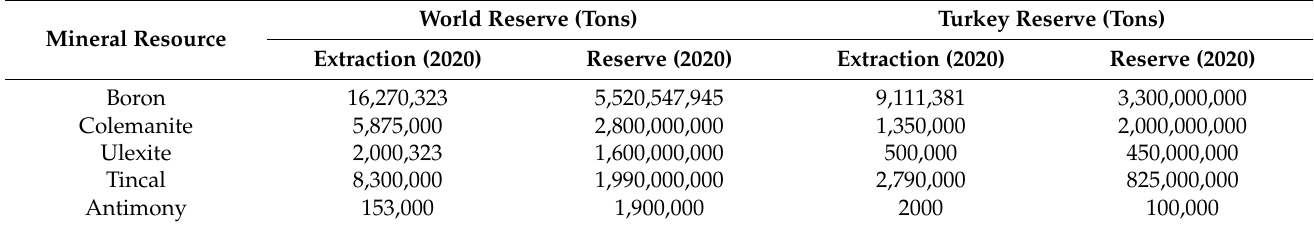
Table 4. Reserve and annual subtraction amounts for the CML method (the year 2020) [32,33]. Mineral